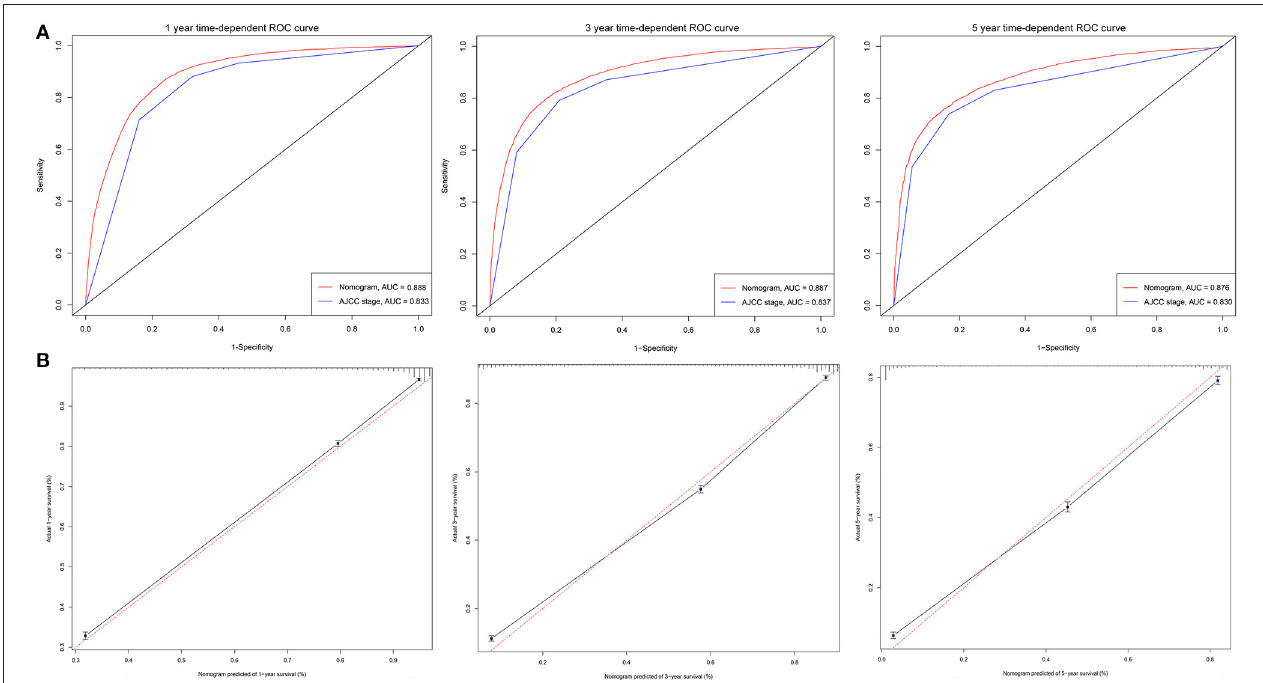
FIGURE 4 | ROC curves and calibration plots for predicting patients-specific survival at 1-, 3-, and 5-year in the training cohorts. (A) ROC curves of the Nomogram and AJCC stage in prediction of prognosis at 1-, 3-, and 5-year point in the training set. (B) The calibration plots for predicting patient survival at 1-, 3-, and 5-year point in the training set. ROC, receiver operating characteristic curve; AUC, areas under the ROC